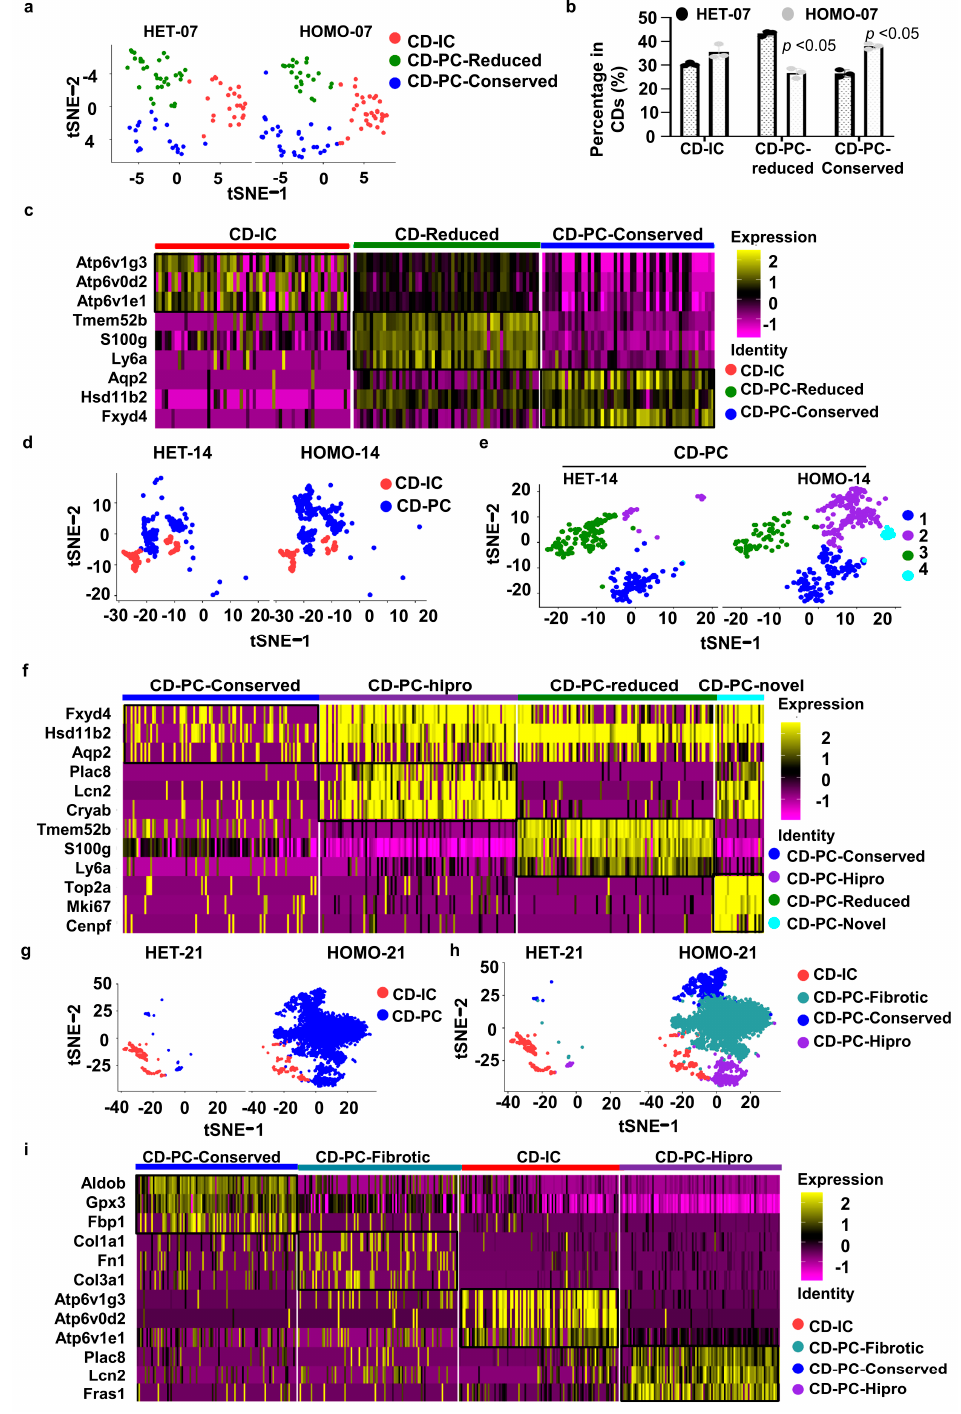
Figure 2. Identification of sub-populations of collecting duct cells at different cyst formation stages of Pkd1 heterozygous and homozygous kidneys. ( a – c ) Identification and characterization